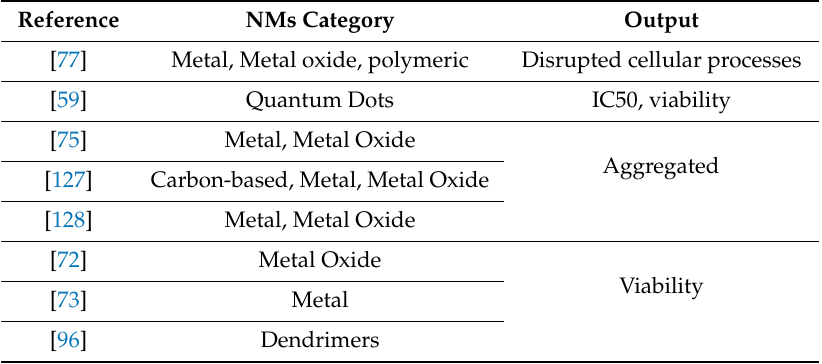
Table 9. Endpoints predicted by Bayes models extracted from the studies